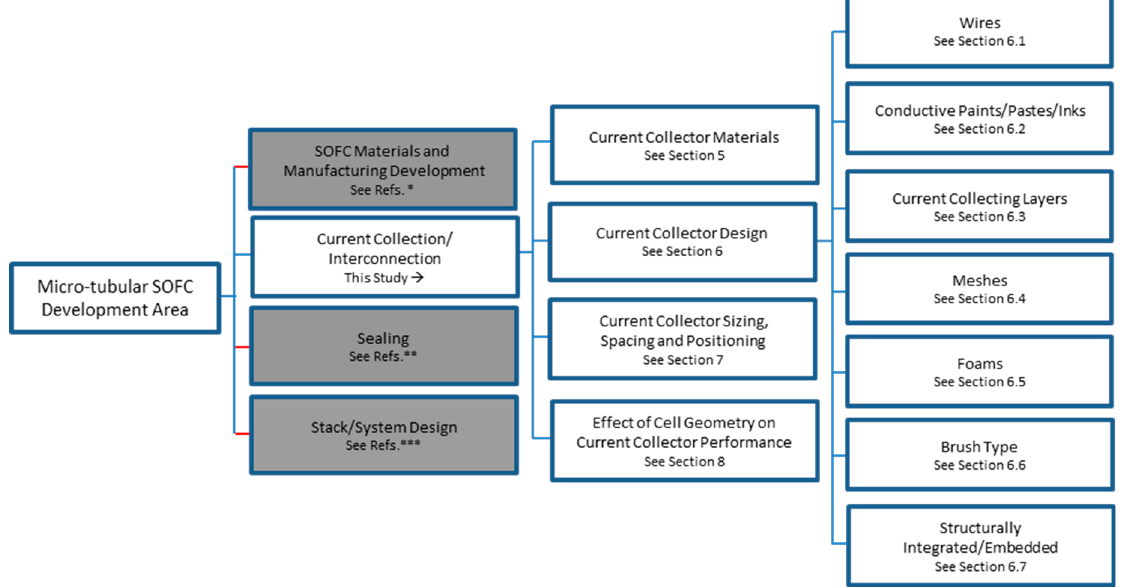
Figure 3. Key areas of development in micro-tubular solid oxide fuel cell (SOFC) technology and breakdown of current collection/interconnection topics covered in this review. References * ([20–25]), ** ([26,27]), *** ([28–30]).